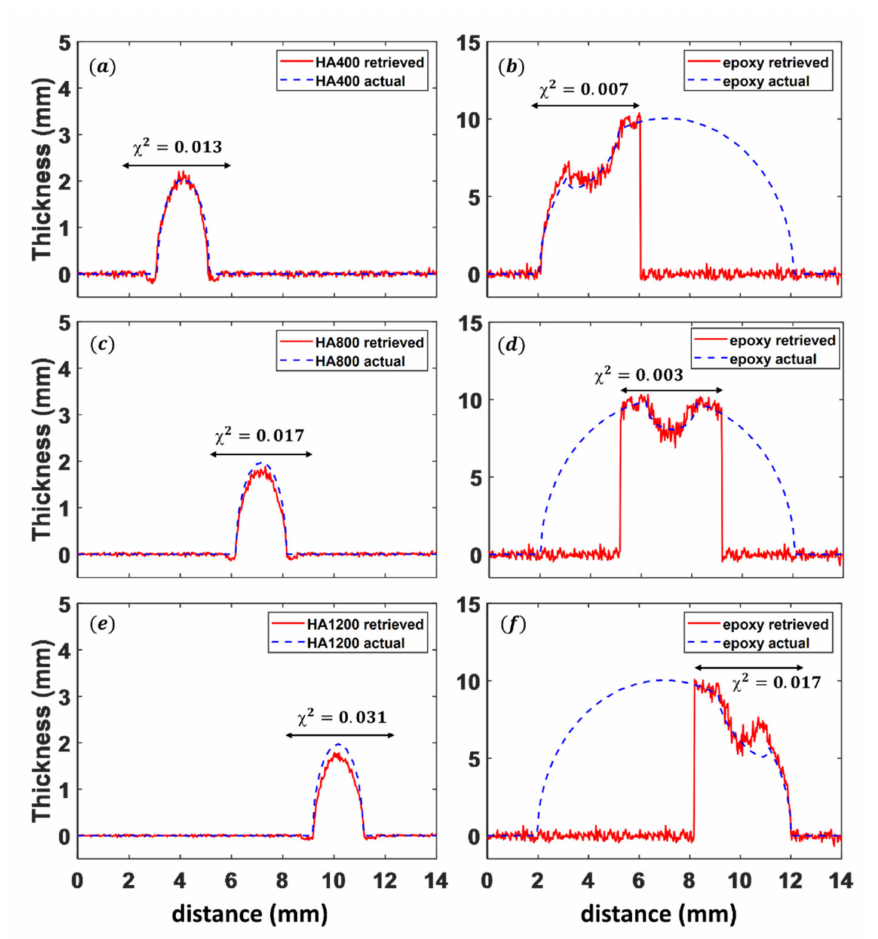
Figure 7. Comparison of the retrieved thickness (red solid lines) to the ‘actual’ thickness (blue dashed lines) determined from the manufacturer’s specifications for the separation of ( a , b ) HA400, ( c , d ) HA800, and ( e , f ) HA1200 from the surrounding epoxy matrix. The sudden drop in intensity in ( b , d , f ) are due to the application of a mask at the detector plane to remove the transmission due to the other inserts. Note that 100 vertical pixels were binned to improve the experimental SNR. The calculated χ 2 error inside the indicated distance range shown by black arrows, can be seen on each plot. The experimental data of ( c – f ) were taken at a tube voltage of 80